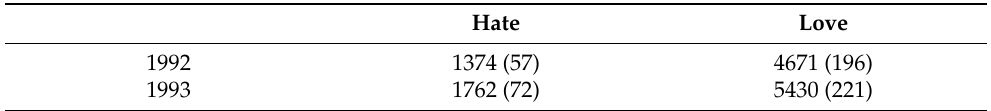
Table 5. Frequencies of hate and love in the years 1992 and 1993 in COCA (relative frequencies per 1m words between brackets).